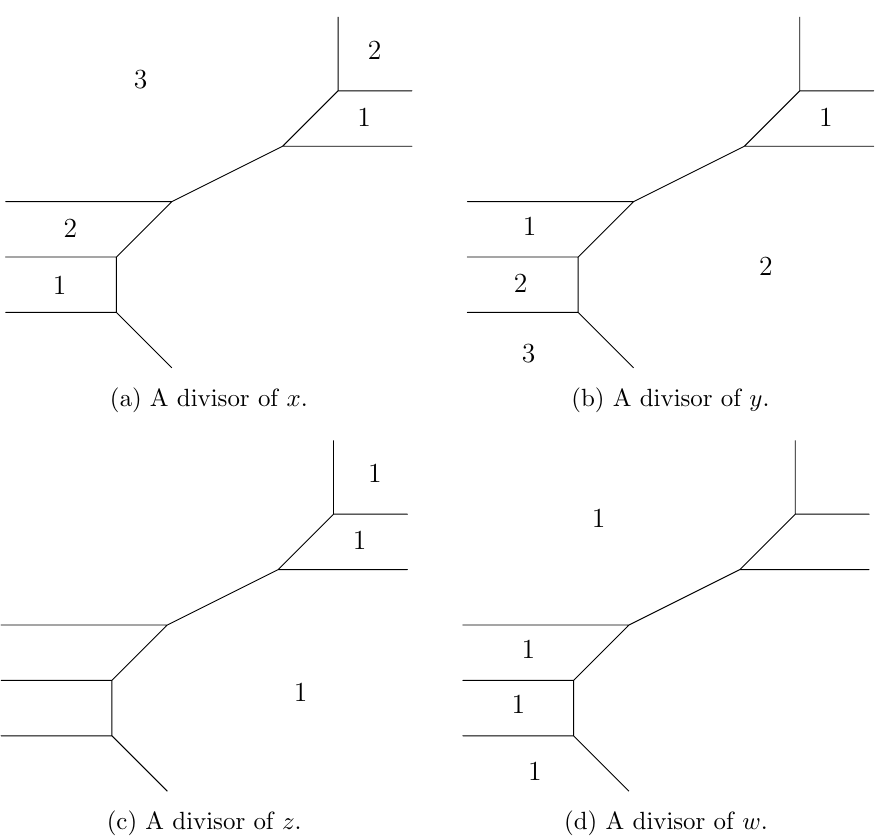
Figure 6. Divisors associated to the elementary functions x; y; z; w in the resolved three-fold ] CY 3 2 ; 3